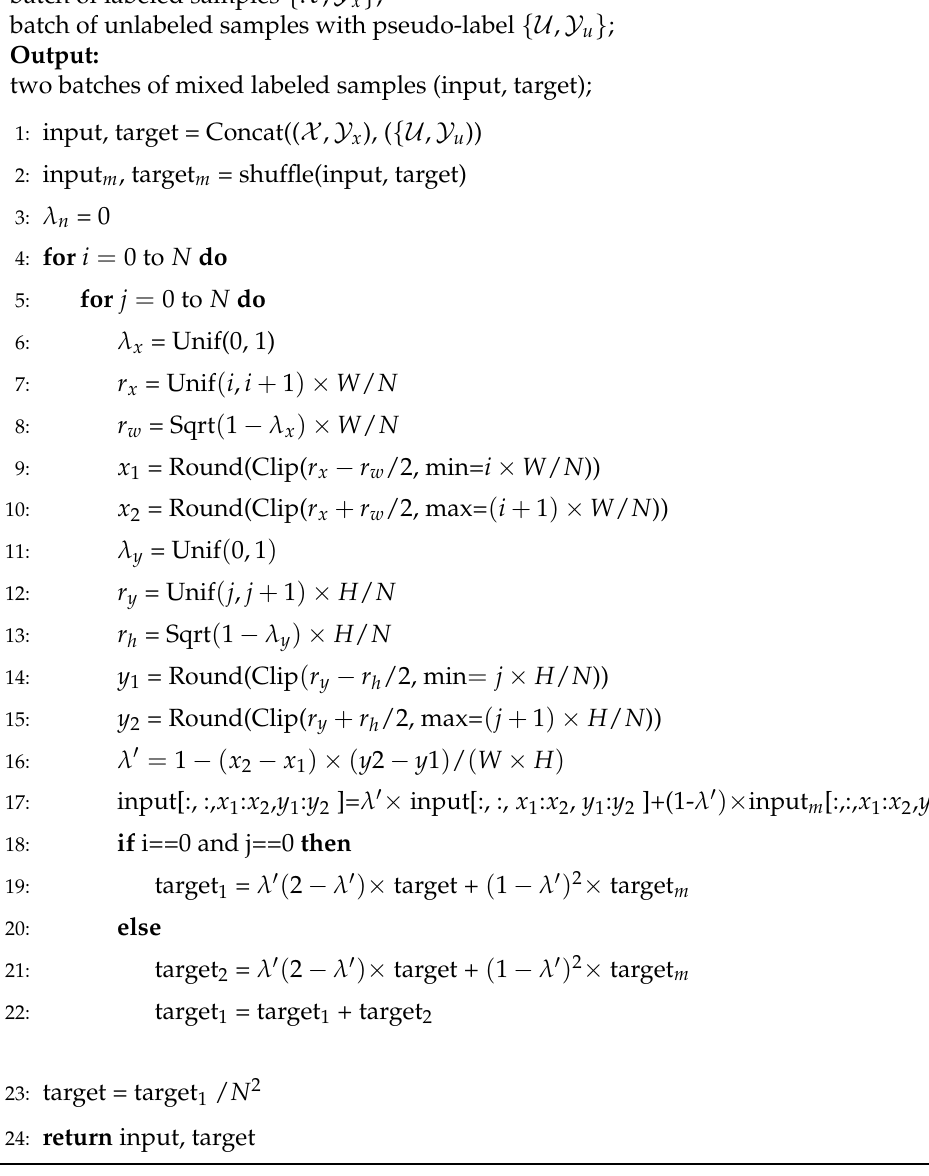
Algorithm 1. Pseudocode for the MBM semi-supervised learning